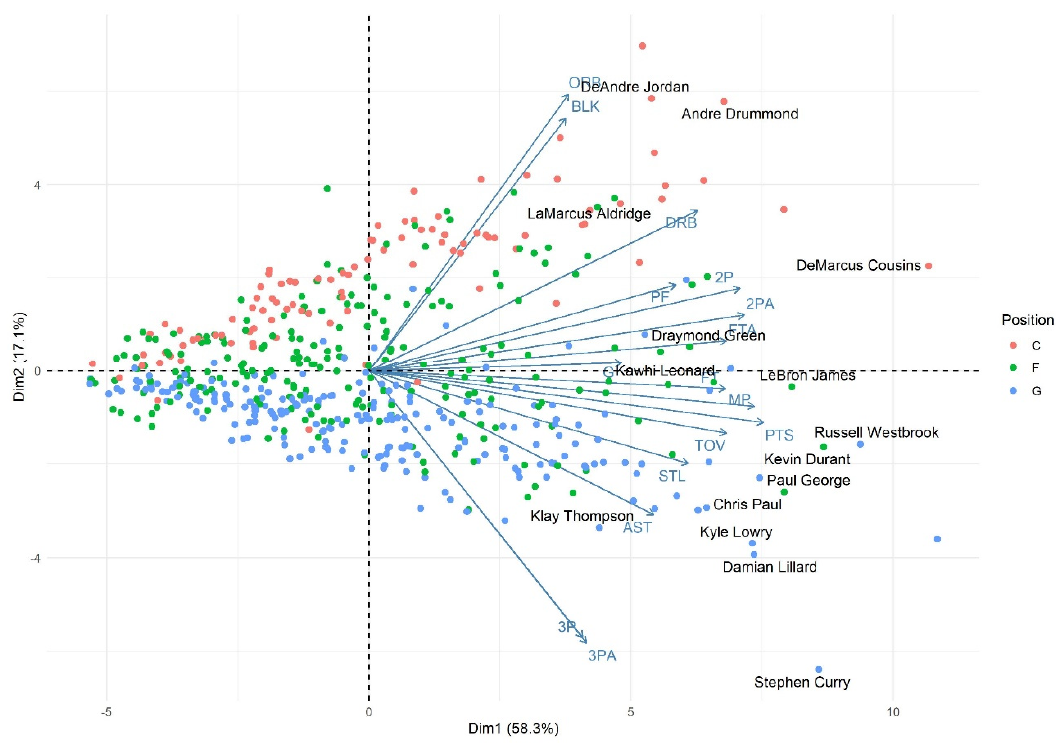
Figure A3 . Principal Component Analysis of active players in the 2015–16 NBA Season.